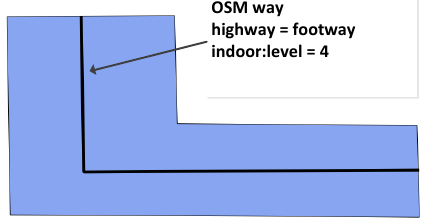
Figure 3. An area with a regular shape.